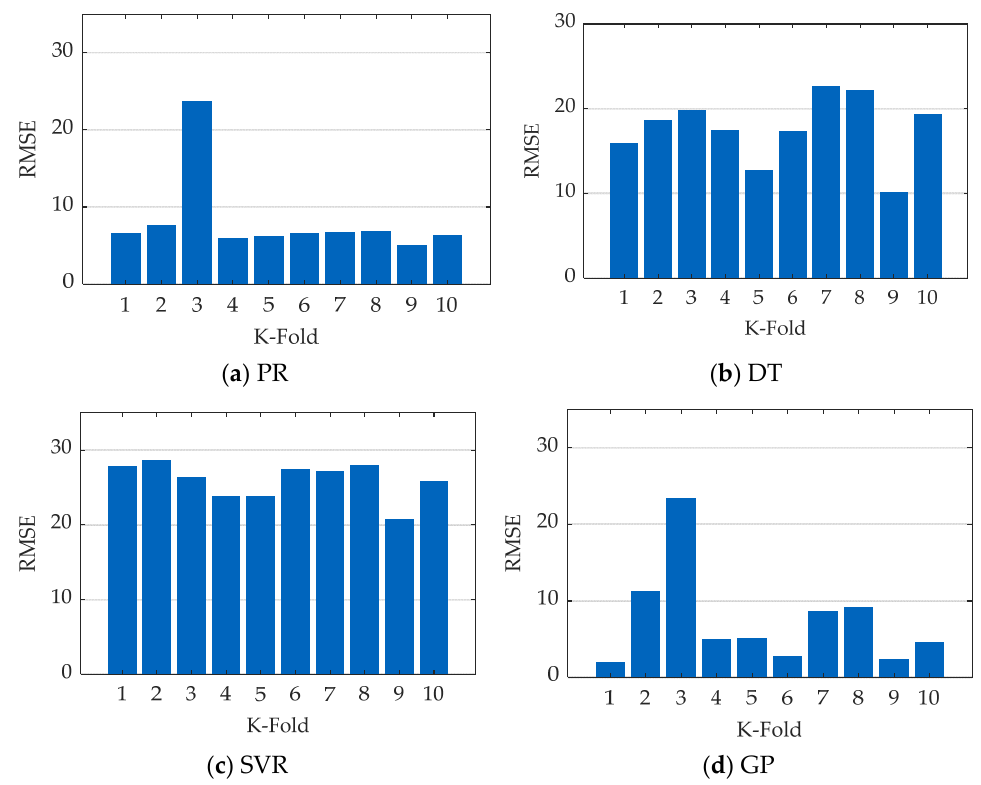
Figure 7. RMSE for 10 ‐ fold cross ‐ validation of the PR, DT, SVR and GP models for Use Case 1.